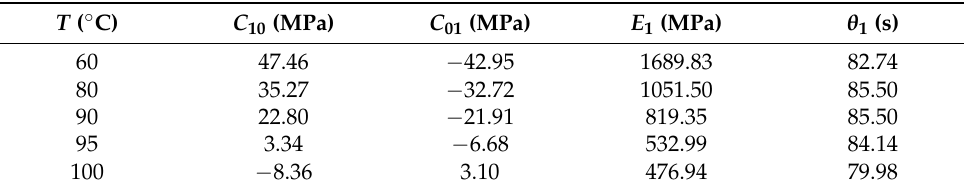
Table 3. Values of the parameters in modified ZWT model at environmental temperature from 60 to 100°C.